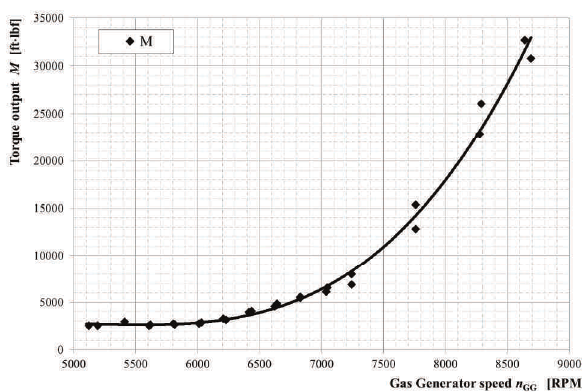
Fig. 14. Approximated function and the results of the measurements of torque output M, recorded for steady-state operation of LM-2500 engine, in relation to gas generator speed n GG